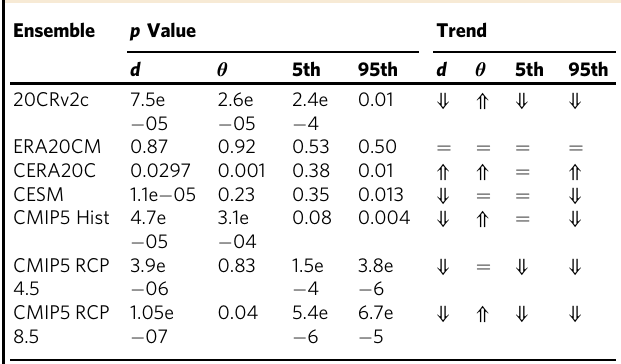
Arrows ( ⇓ / ⇑ ) represent signi fi cant decreasing/increasing trends at the 5% level, respectively. The equal sign ( = ) denotes absence of signi fi cant trends. The test statistics is described